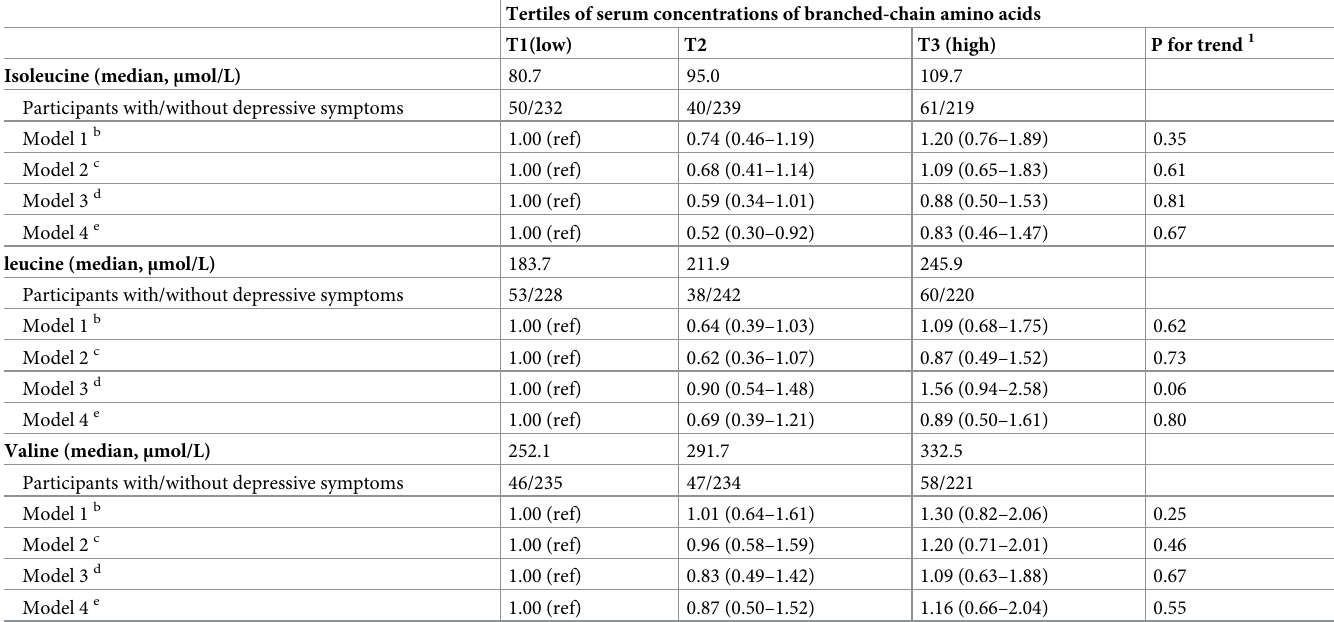
Table 3. Associations of serum concentrations of branched-chain amino acids with depressive symptoms. Tertiles of serum concentrations of branched-chain amino